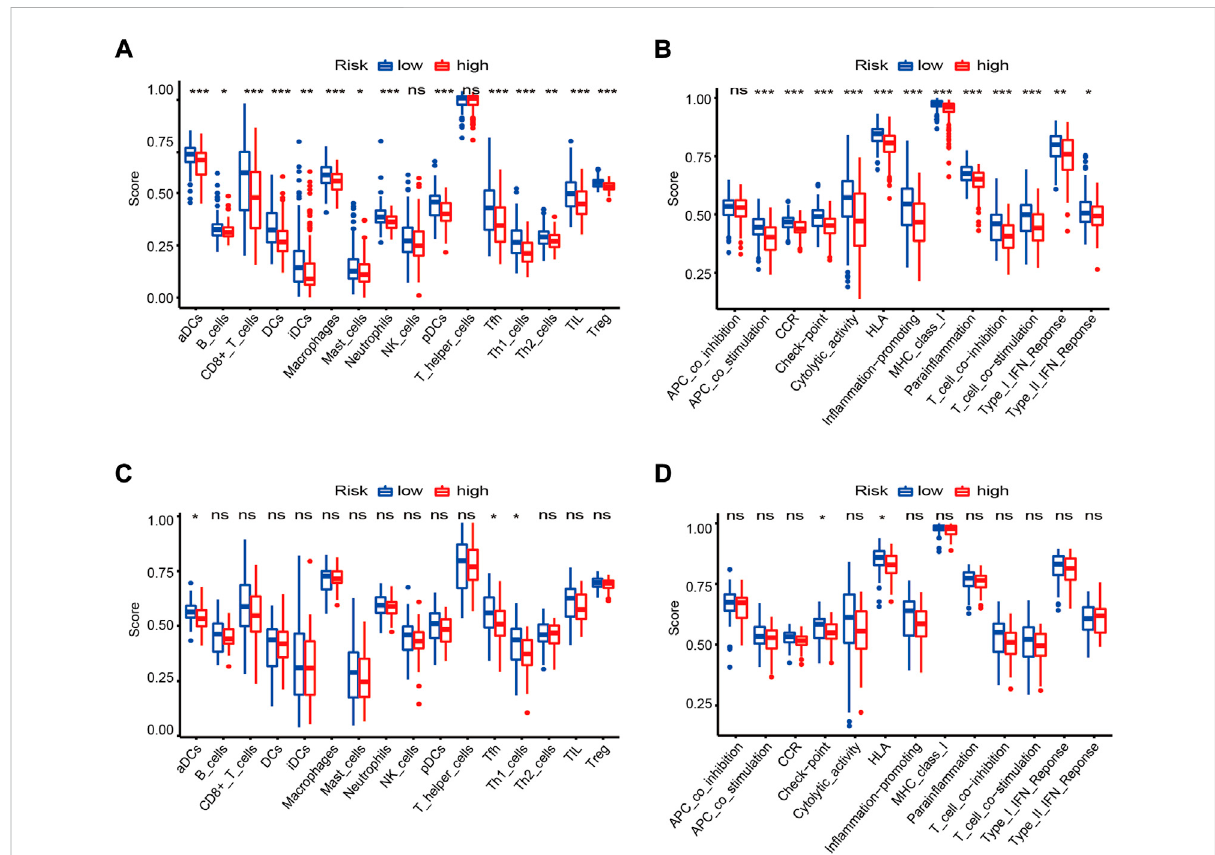
FIGURE 9 Landscapes of immune cell in fi ltration and immune-related functions between risk groups in the GSE32062 (A,B) and ICGC (C,D) cohorts. Boxplots of ssGSEA scores in 16 types of immune cells (A,C) and 13 immune-related functions (B,D) are presented. *adj. p < 0.05; **adj. p < 0.01; ***adj. p < 0.001; ns, not signi fi cant. ICGC, International Cancer Genome Consortium; GSEA, gene set enrichment analysis; CCR, cytokine-cytokine receptor; HLA, human leukocyte